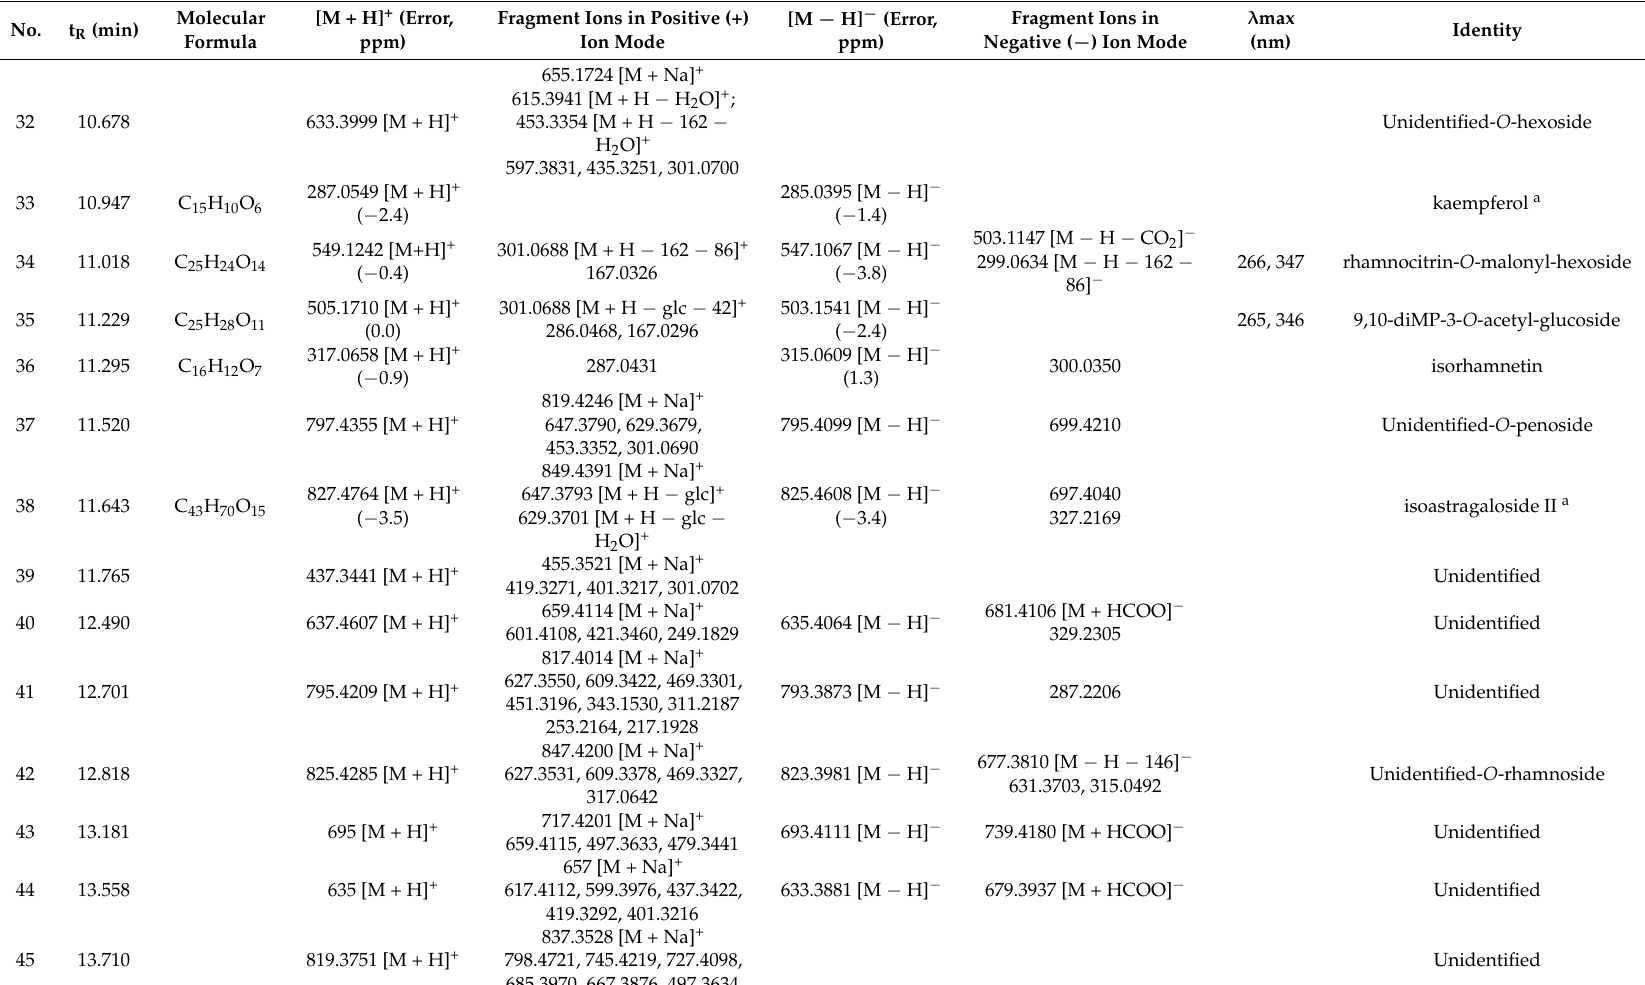
Table 3. Compounds identified in ME of AMF by UPLC-Q-TOF MS